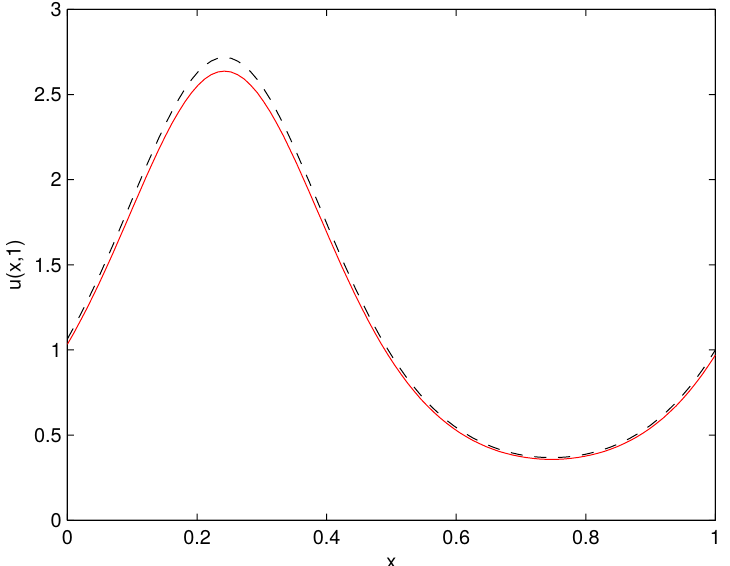
Figure 2. The exact and numerical solutions of u ( x ,1 ) . The exact solution is shown with dashes